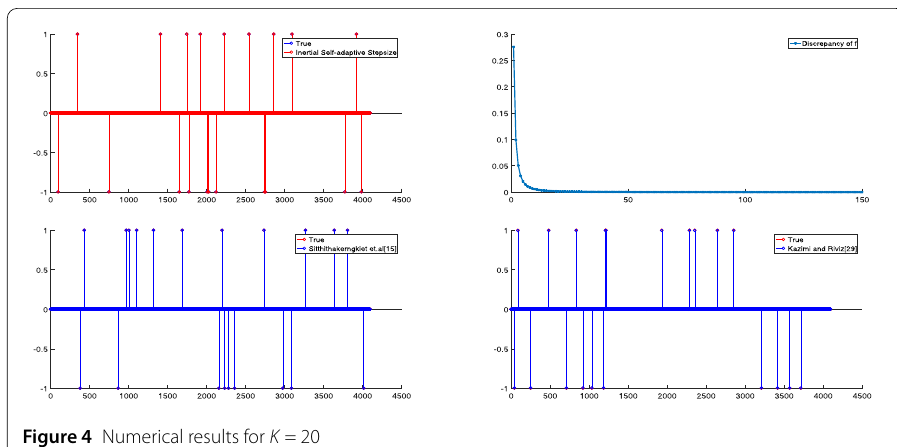
Figure 4 Numerical results for K = 20